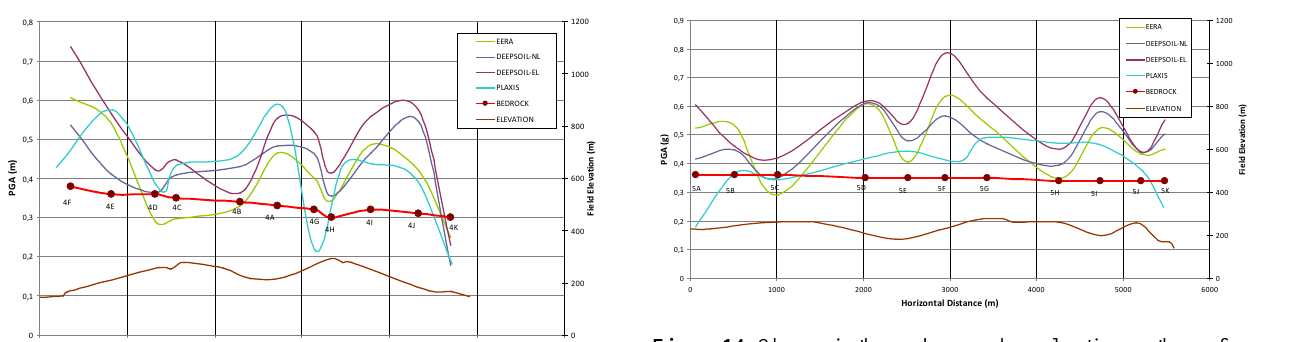
Figure 14. Change in the peak ground acceleration on the surface for 5-5’ section